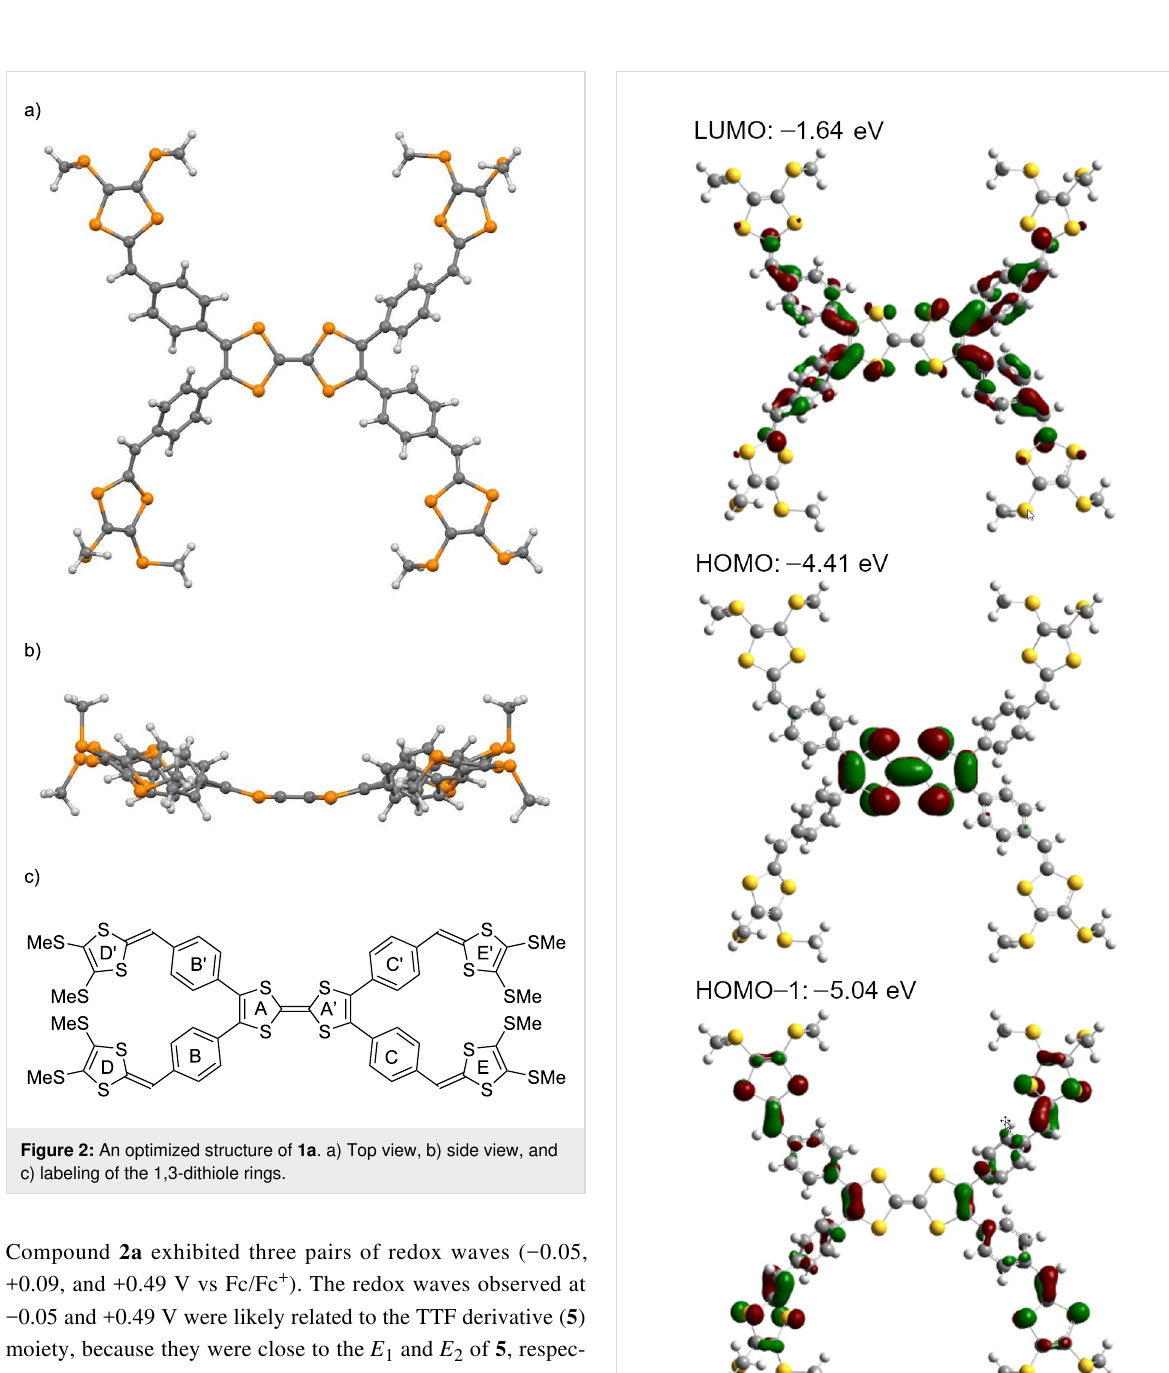
Compound 2a exhibited three pairs of redox waves ( − 0.05, +0.09, and +0.49 V vs Fc/Fc + ). The redox waves observed at − 0.05 and +0.49 V were likely related to the TTF derivative ( 5 ) moiety, because they were close to the E 1 and E 2 of 5 , respec- tively (Table 2). The comparison of the peak currents of each wave indicated that the redox wave observed at +0.09 V